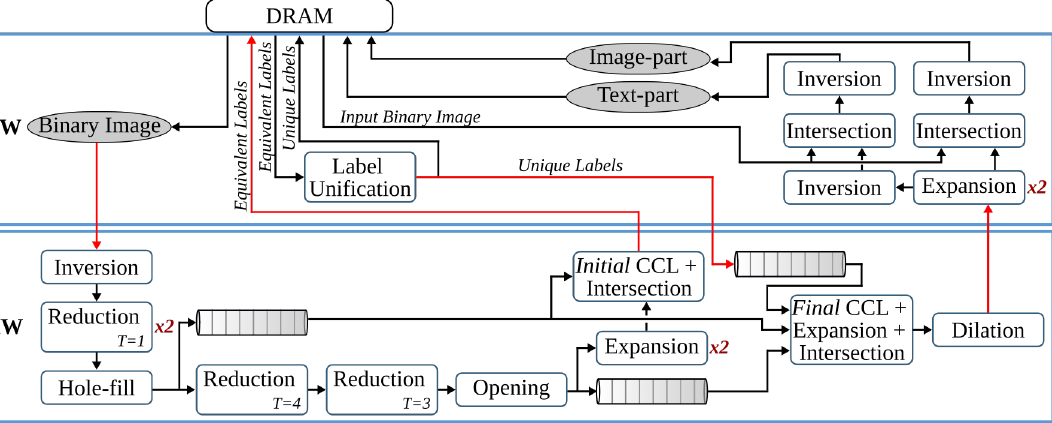
Figure 5. The system-level architecture of the i DocChip text and image segmentation step.